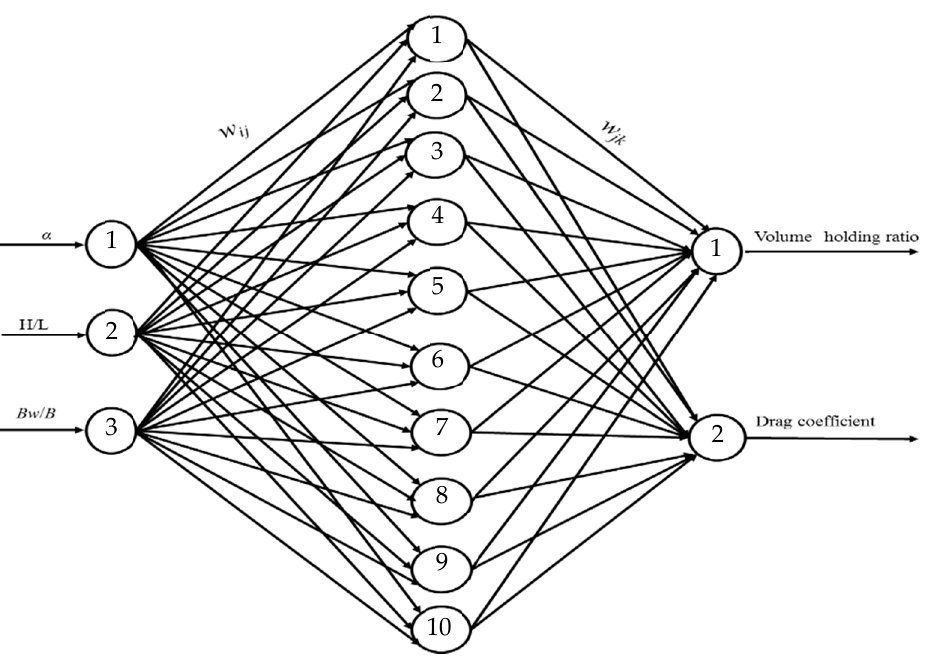
Figure A1. Constructed BP neural network.